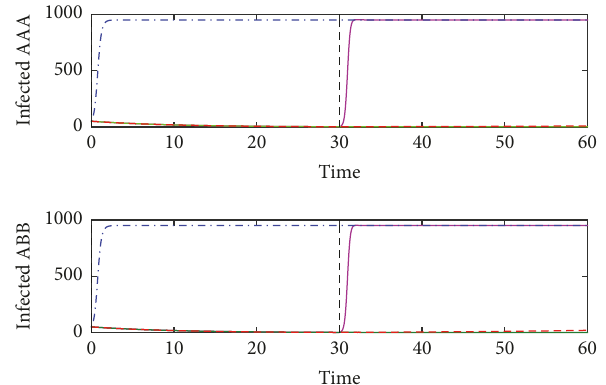
Figure 5: Simulation for the number of infected stems for AAA- genome and ABB-genome. The purple line shows, after 𝑡 = 30 , all controlsarewithdrawn. Reddashedandgreenlinesindicatethecase when only (B1) or (B3) is continued after 𝑡 = 30